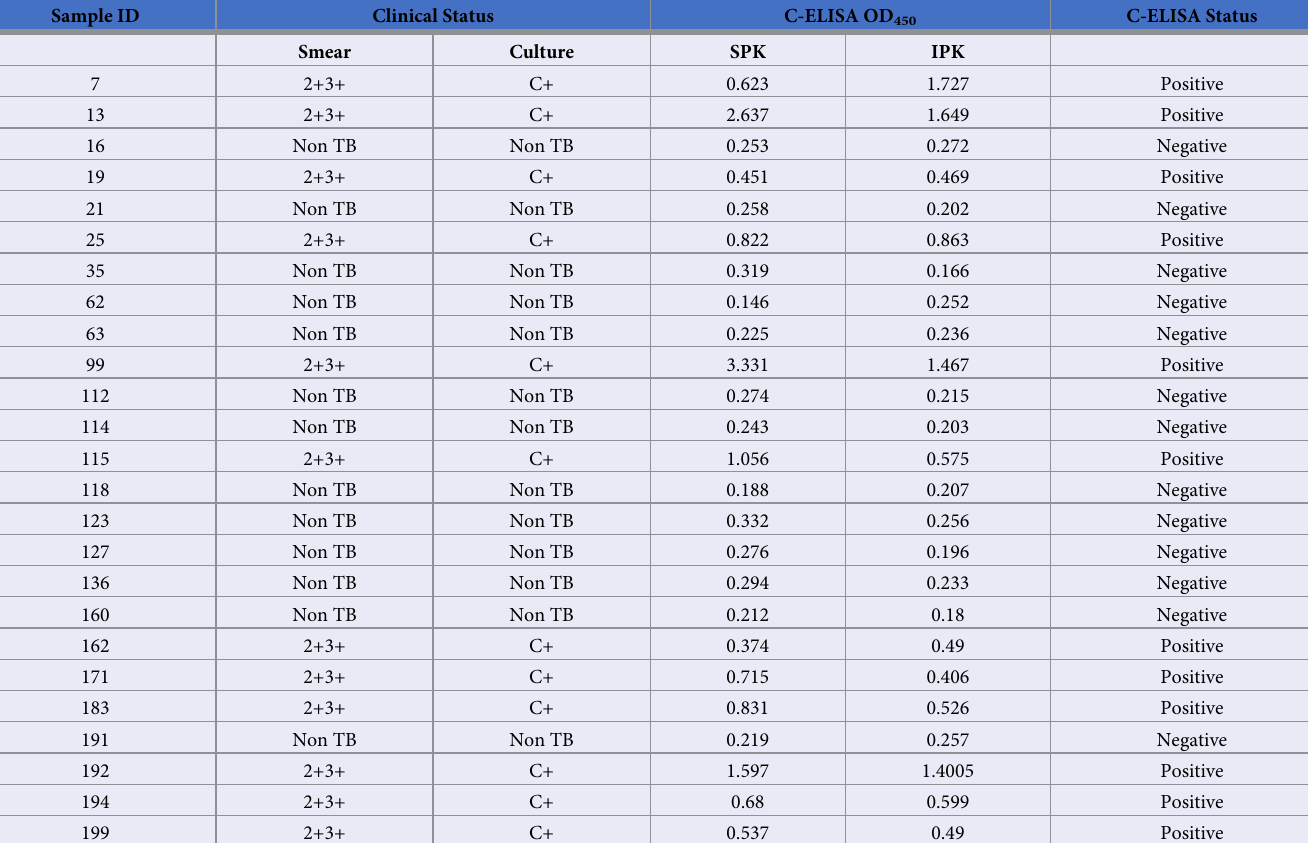
Table 1. Twenty five clinically characterized urine samples analyzed in a capture ELISA using both SPK and IPK as the pretreatment for comparison. A majority of the samples were from Vietnam, included both male and female with ages ranging from 35 to 80. Sample